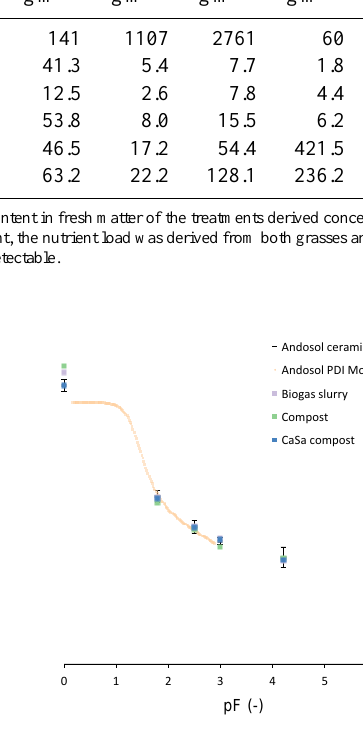
Figure 2. Water retention curve (WRC) of the untreated Andosol and of the soil treated with biogas slurry, standard compost and CaSa compost. The PDI model for the control Andosol was fitted to data measured using the simplified evaporation method. Error indi- cators belong to “Andosol ceramic plate”. Plot data are provided in Tables S1 and